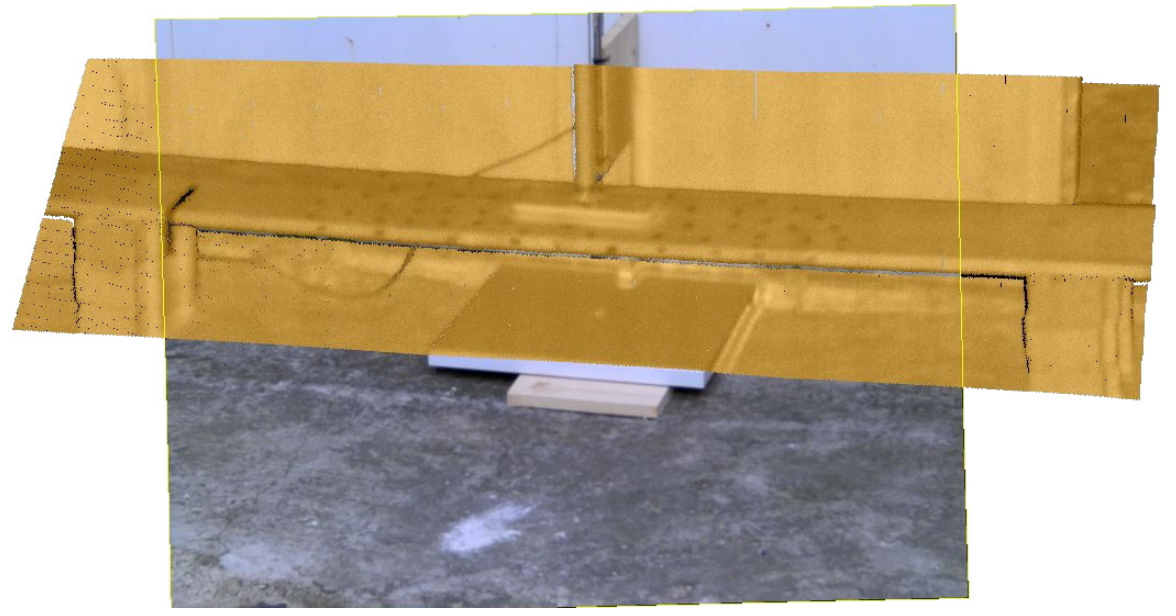
Figure 8. Image and point cloud overlap (Source: Own compilation).